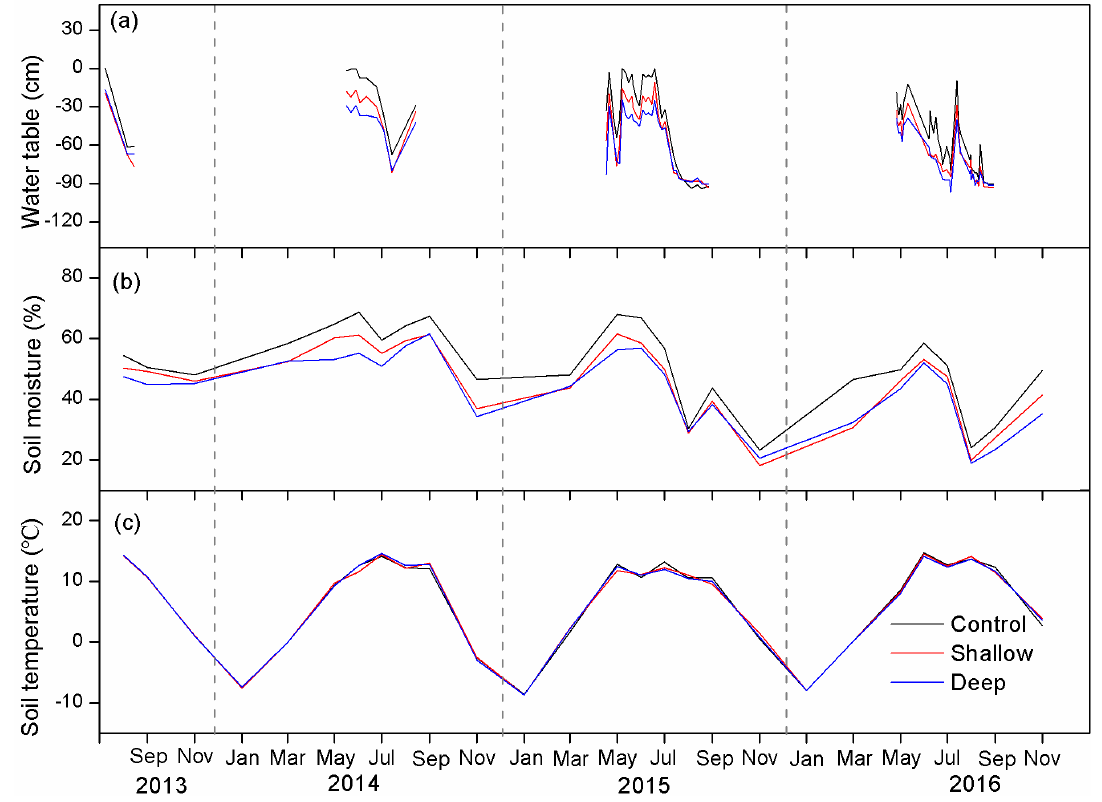
Figure 3. Variations in (a) water table height, (b) soil moisture, and (c) soil temperature for the control, shallow and deep water table treatments during the experiment. Error bars represent ±1 Standard